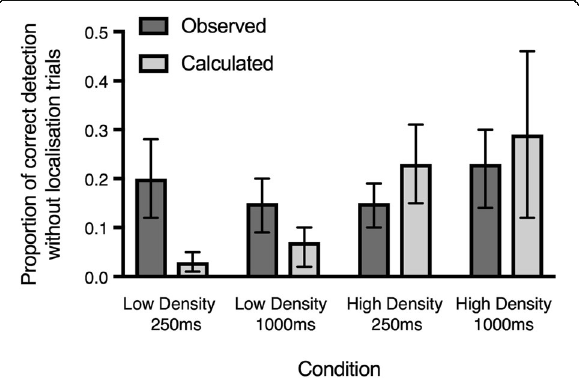
Fig. 8 The proportion of correct ‘ detection without localisation ’ trials ( dark grey bars ) compared to the proportion of calculated (guessing) trials for a hypothetical ideal observer ( light grey bars ) for low- and high-density mammograms plotted by duration (250 ms, 1000 ms). Error bars represent 95% confidence